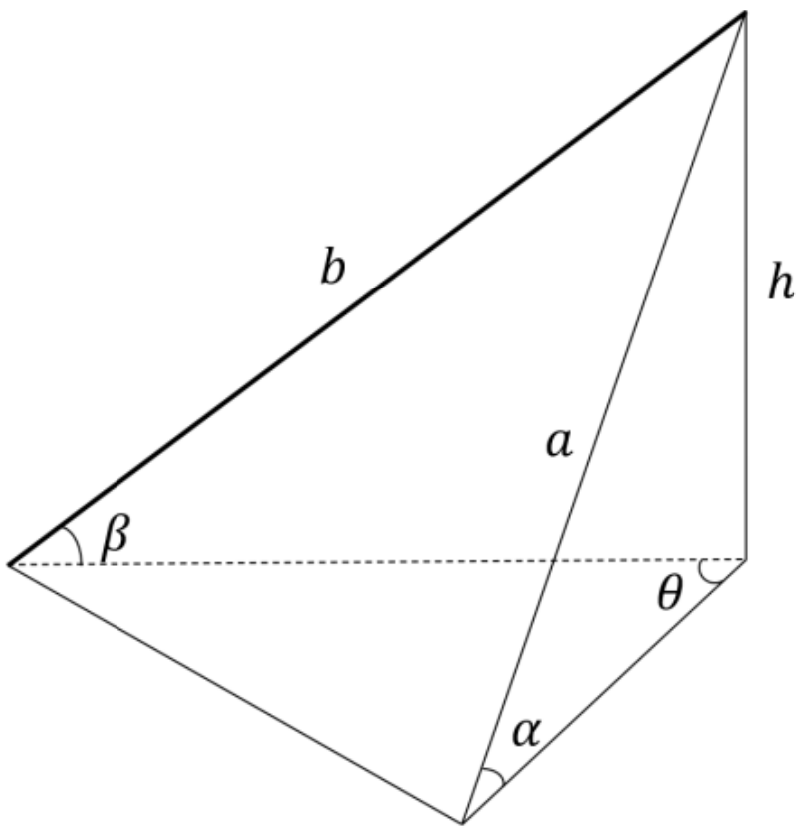
Figure 6. Schematic diagram of mountain terrain variables: a represents the straight line along the slope gradient of the mountain, b represents the road, h represents the height of the indicated position, θ represents the road-gradient angle, α represents the slope at the steepest direction directly obtained from a DEM and β represents the required road-direction slope.